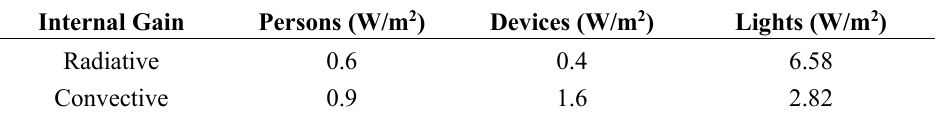
Table 8. Internal gain for residential building